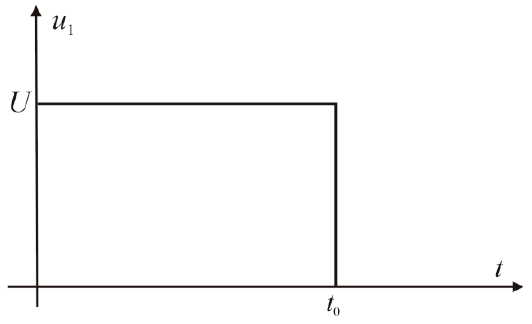
Figure 3. Single voltage pulse.